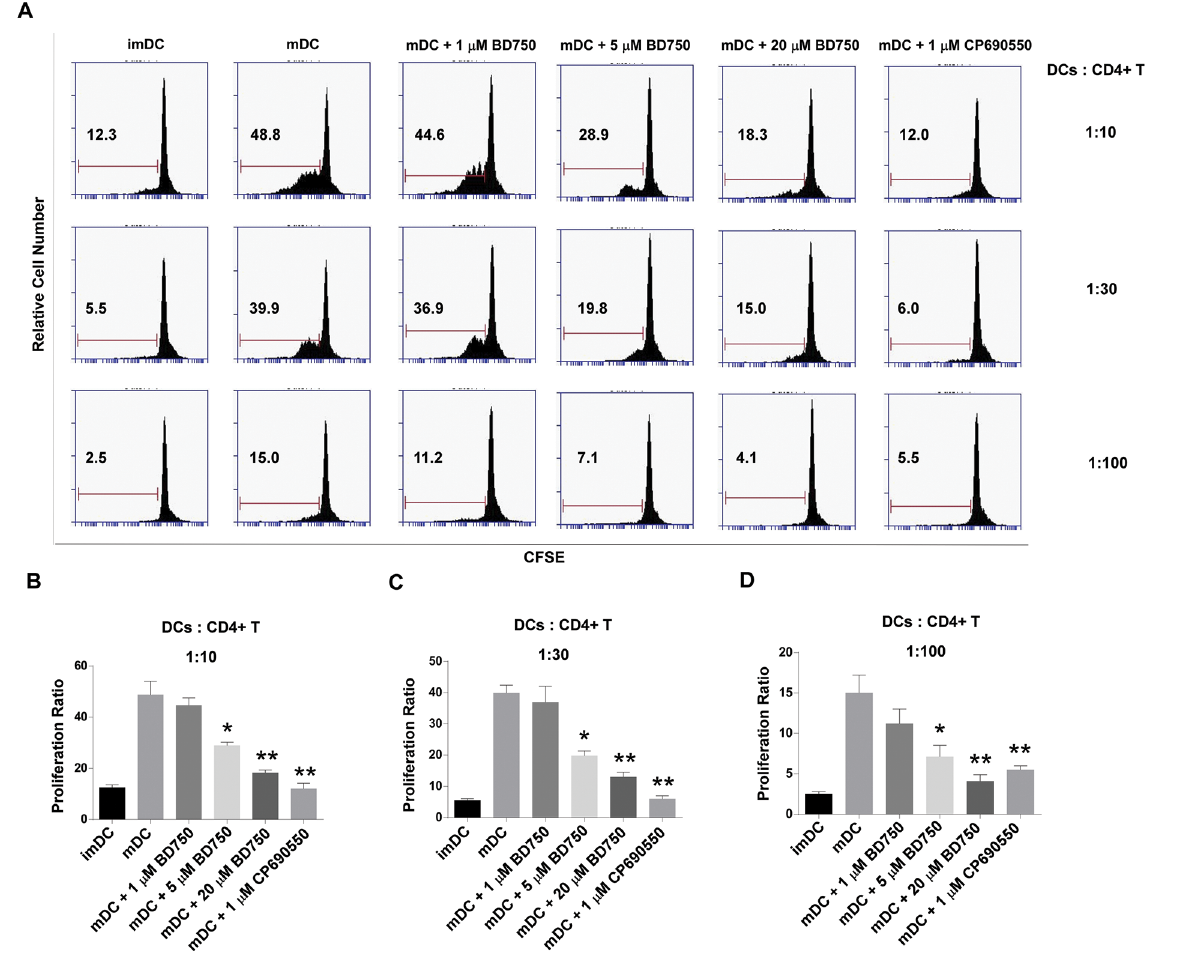
Figure 4. BD750-treated DC impairs allogeneic antigen-stimulated T cell proliferation in vitro . ImDCs, mDCs and BD750-pretreated DCs (12 h) were mixed in triplicate with carboxyfluo-resceinsuccinimidyl ester–labeled allogeneic naive CD4 + CD25 – T cells for 72 h at different ratios (DC:CD4 + T, 1:10, 1:30 and 1:100), and the proliferation of T cells was determined by flow cytometry. Data are representative his- tograms or expressed as the mean ± SEM of three independent experiments. (A) Flow cytometry analysis. (B–D) Quantitative analysis. * P < 0.05, ** P < 0.01 versus the mDC